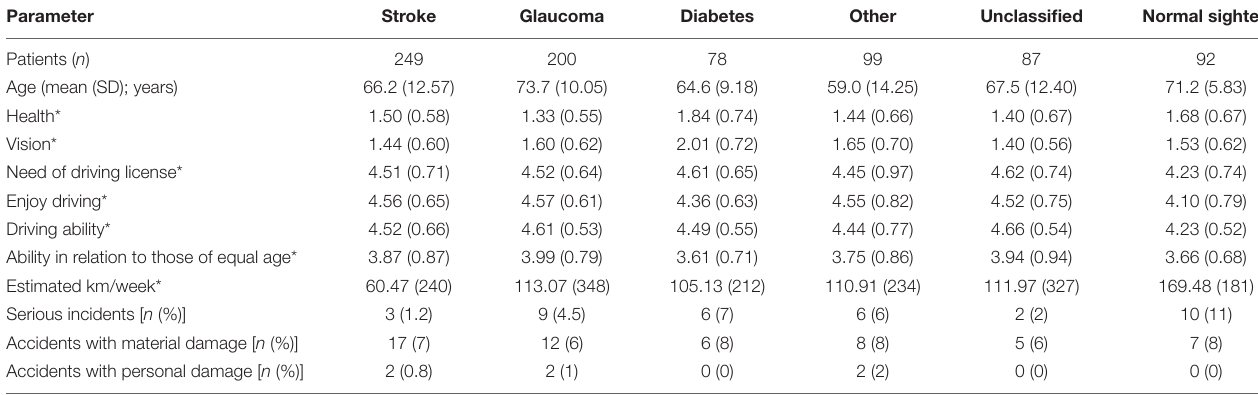
TABLE 2 | Descriptive statistics (mean values and SD) for background survey data, for normally sighted and all VFL etiology groups. Parameter Stroke Glaucoma Diabetes Other Unclassified Normal sighted